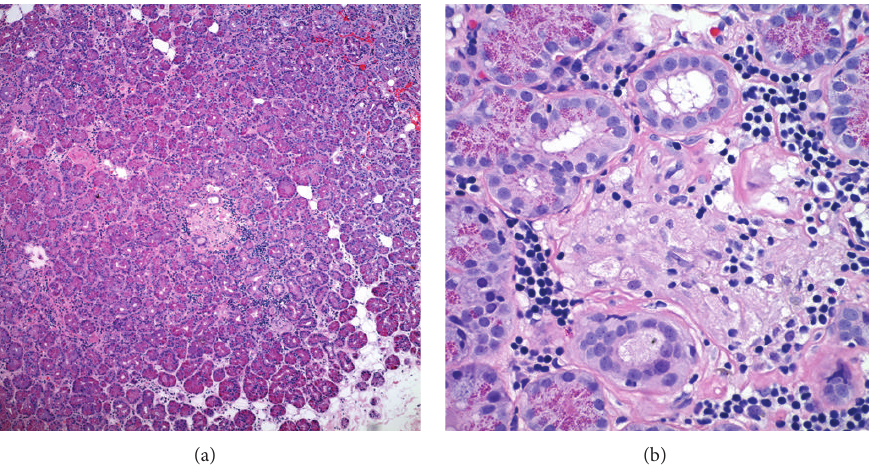
Figure 3: (a) Hematoxylin and eosin stain at 100x magnification, showing a lacrimal gland section with small nonnecrotizing granulomas. (b) Hematoxylin and eosin stain at 400x magnification, showing a small nonnecrotizing granuloma with epithelioid cells and